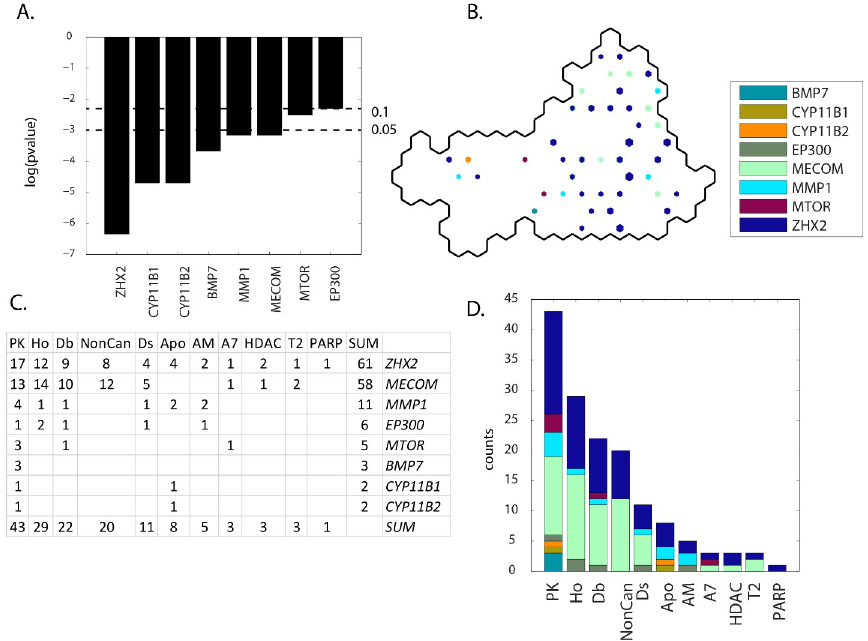
Fig 10. Results for group B(meta-clades 7 through 9). The SOM DTP region displayed in Panel B represents the boundary for meta-clades 7 through 9 (see the white border in Fig 8 Panel A ). S7 master_appendix sheet gp_B lists the table in Panel C. See the legend of Fig 9 for details. S14 master_appendix sheet gp_B_FDA lists the FDA compounds associated with these defective genes.